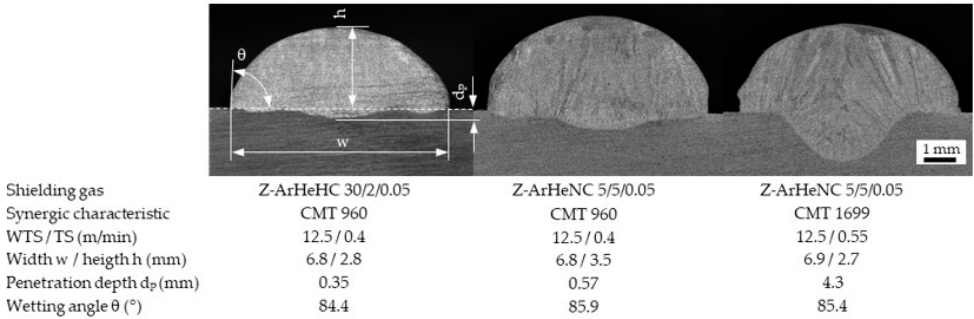
Figure 2. Seam geometries of single beads on the plate (Y–Z plan) welded with different shielding gases and CMT lines.